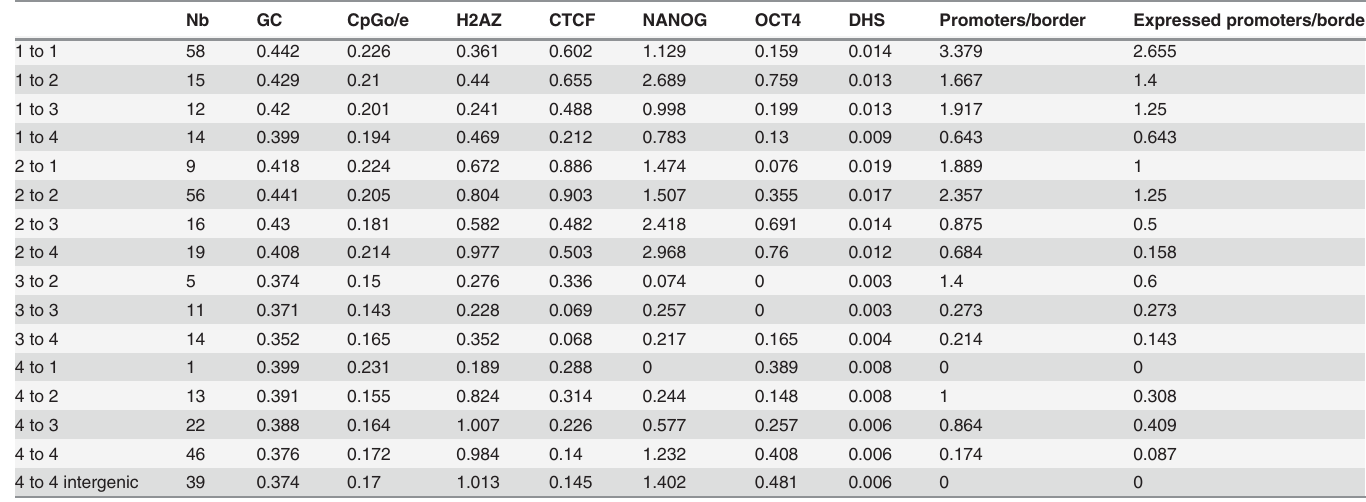
Table 5. Sequence, epigenetic and gene characteristics of speci fi c (n = 1) replication U-domain borders of H1hesc that switch from state ECi to Cj.